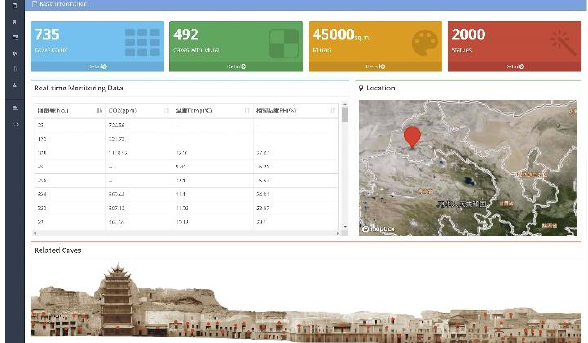
Figure 7. Heritage Site resource